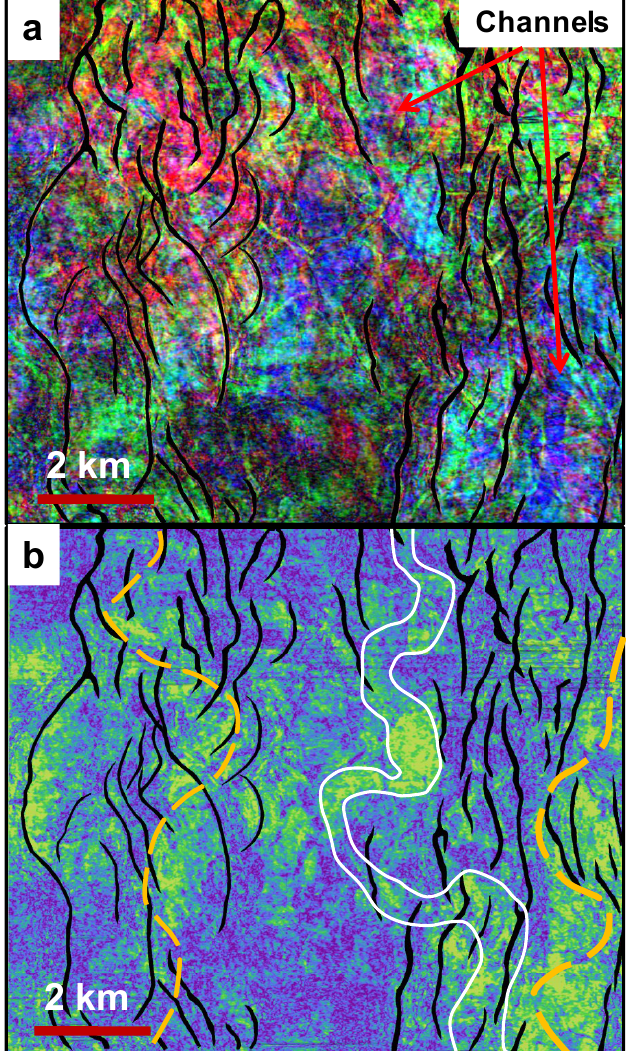
Figure 7: RGB blending of 12 Hz, 25Hz and 45Hz (a) and Spectral decomposition 45 slice (b) in Horizon slice D. The interpretation shows the channel pattern identified from RGB blended image. White line indicates meander belt and dashed orange lines indicate